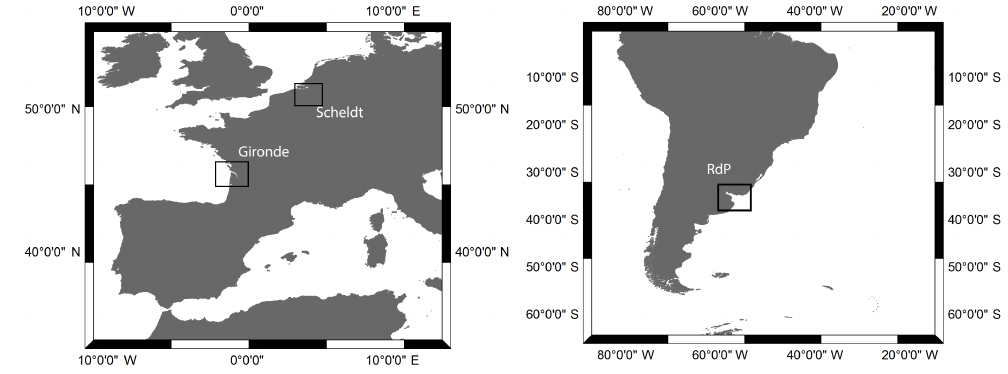
Figure 1. Locations of the study sites: Scheldt (Belgium), Gironde (France), and Río de La Plata